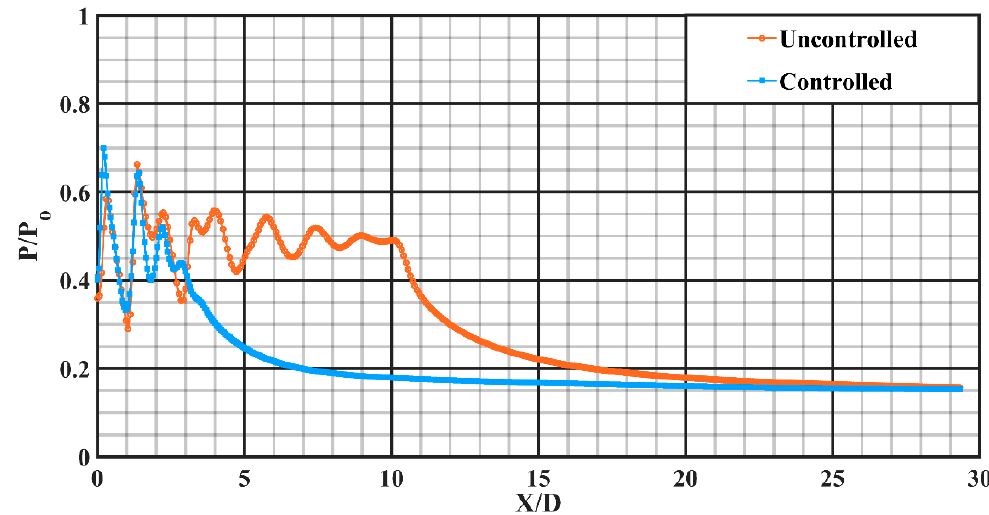
Figure 14. Decay of Jet centerline pressure for Mach 1.8 at NPR 7.